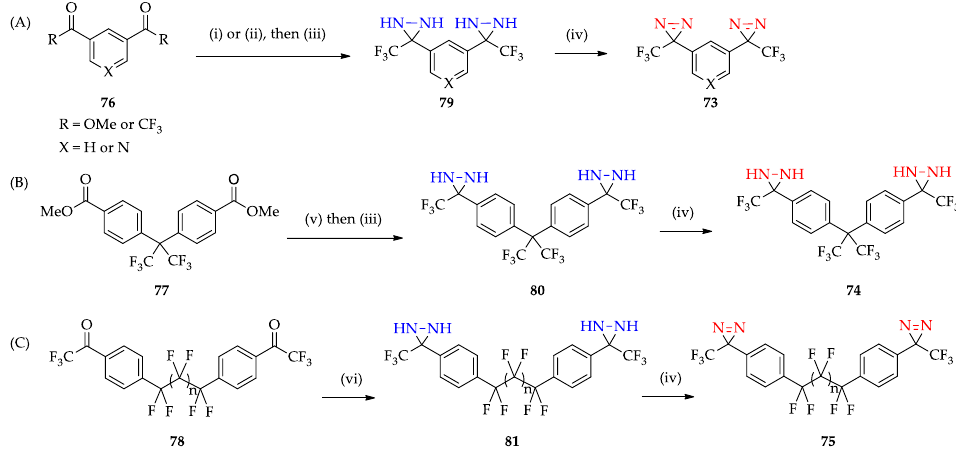
Figure 10. Fluorous 3H -diazirine-based crosslinker: ( A ) Simple bis-diazirine 73 , ( B ) 1st generation bis-diazirine 74 , ( C ) 2nd-generation bis-diazirine 75 . Conditions: (i) 1. NH 2 OH.HCl, EtOH, reflux, 2 h, 2. NaOH(aq), reflux, 2 h, (ii) 1. TMSCF 3 , TBAF, DCM, 2. NH 2 OH.HCl, NaOH, EtOH/H 2 O, reflux, 2 h, (iii)TsCl, NEt 3 , DMAP, DCM, 0 ◦ C, then NH 3 (l), DCM, − 78 ◦ C to r.t, (iv) I 2 , NEt 3 , DCM, 0 ◦ C, (v) 1. TMSCF 3 , TBAF, THF, − 10 ◦ C to r.t. 2. NH 2 OH.HCl, EtOH, reflux, 2 h, (vi) 1. NH 2 OH.HCl, 2. p -TsCl, NEt 3 , 3. NH 3 (l), − 78 ◦ C to